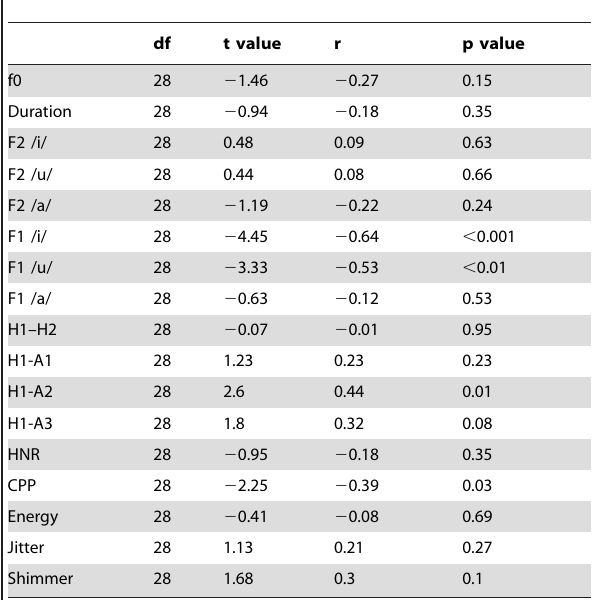
Table 13. Zero-order correlations between vocal attractiveness ratings and each acoustic measure for the 30 male